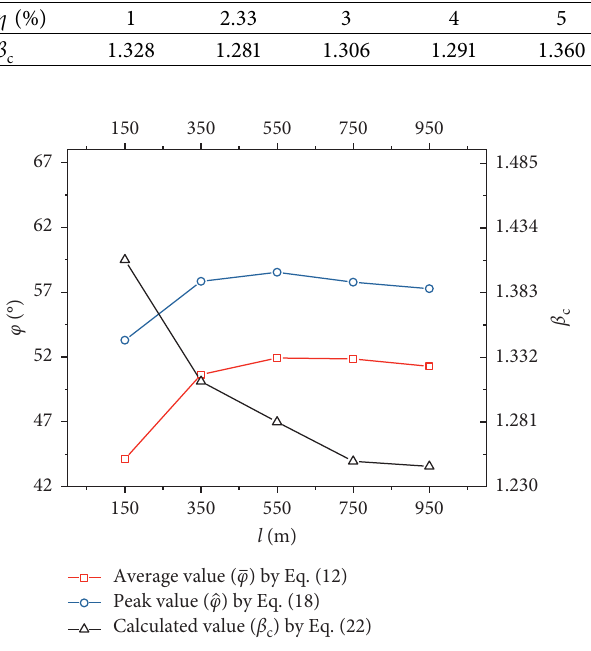
Table 4: Influence of height difference on the dynamic wind load factor of the windage yaw angle.